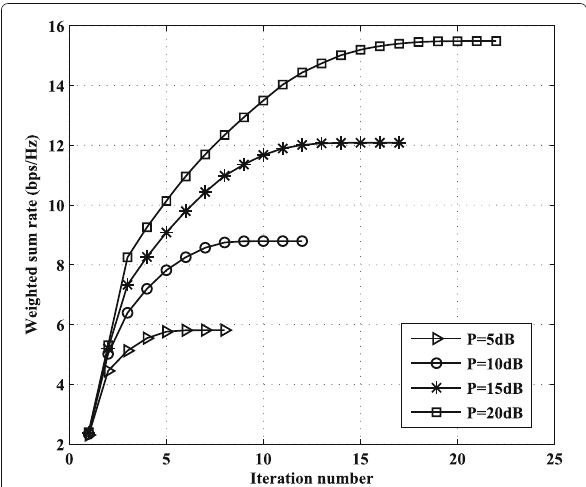
Fig. 3 AO algorithm: convergence of the weighted sum rate